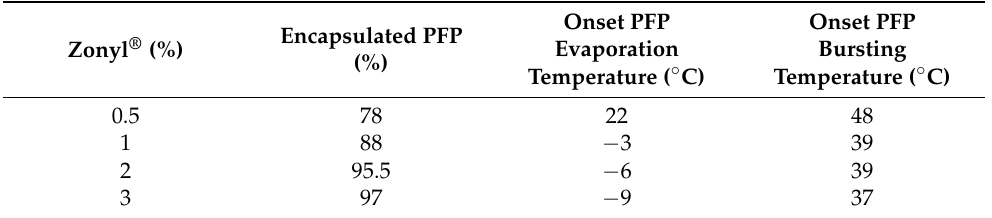
Figure 4. DSC ( A ) and TGA ( B ) curves obtained for PFP based emulsions prepared with 0.5 (black), 1 (red), 2 (green) and 3% (blue) of Zonyl ® . Table 4. Mass percentage, onset evaporation temperature, and onset microbubble bursting temperature of encapsulated PFP as a function of Zonyl ® concentration.